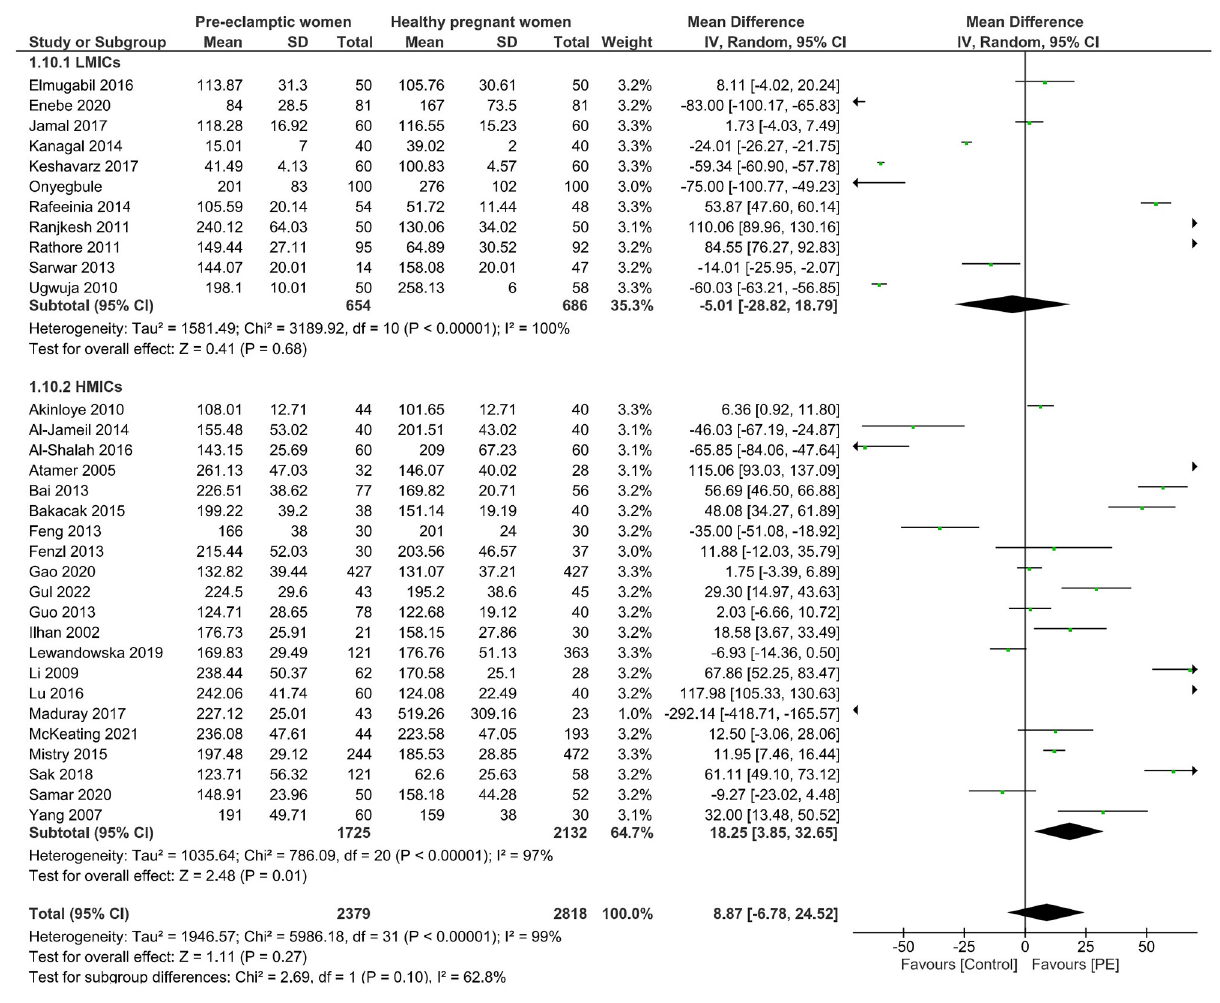
FIGURE 3 | Forest plot of the sub-group analysis. Serum copper levels in women with PE vs. healthy pregnant women from low and lower-middle economies (LMICs) and upper-middle and high-income economies